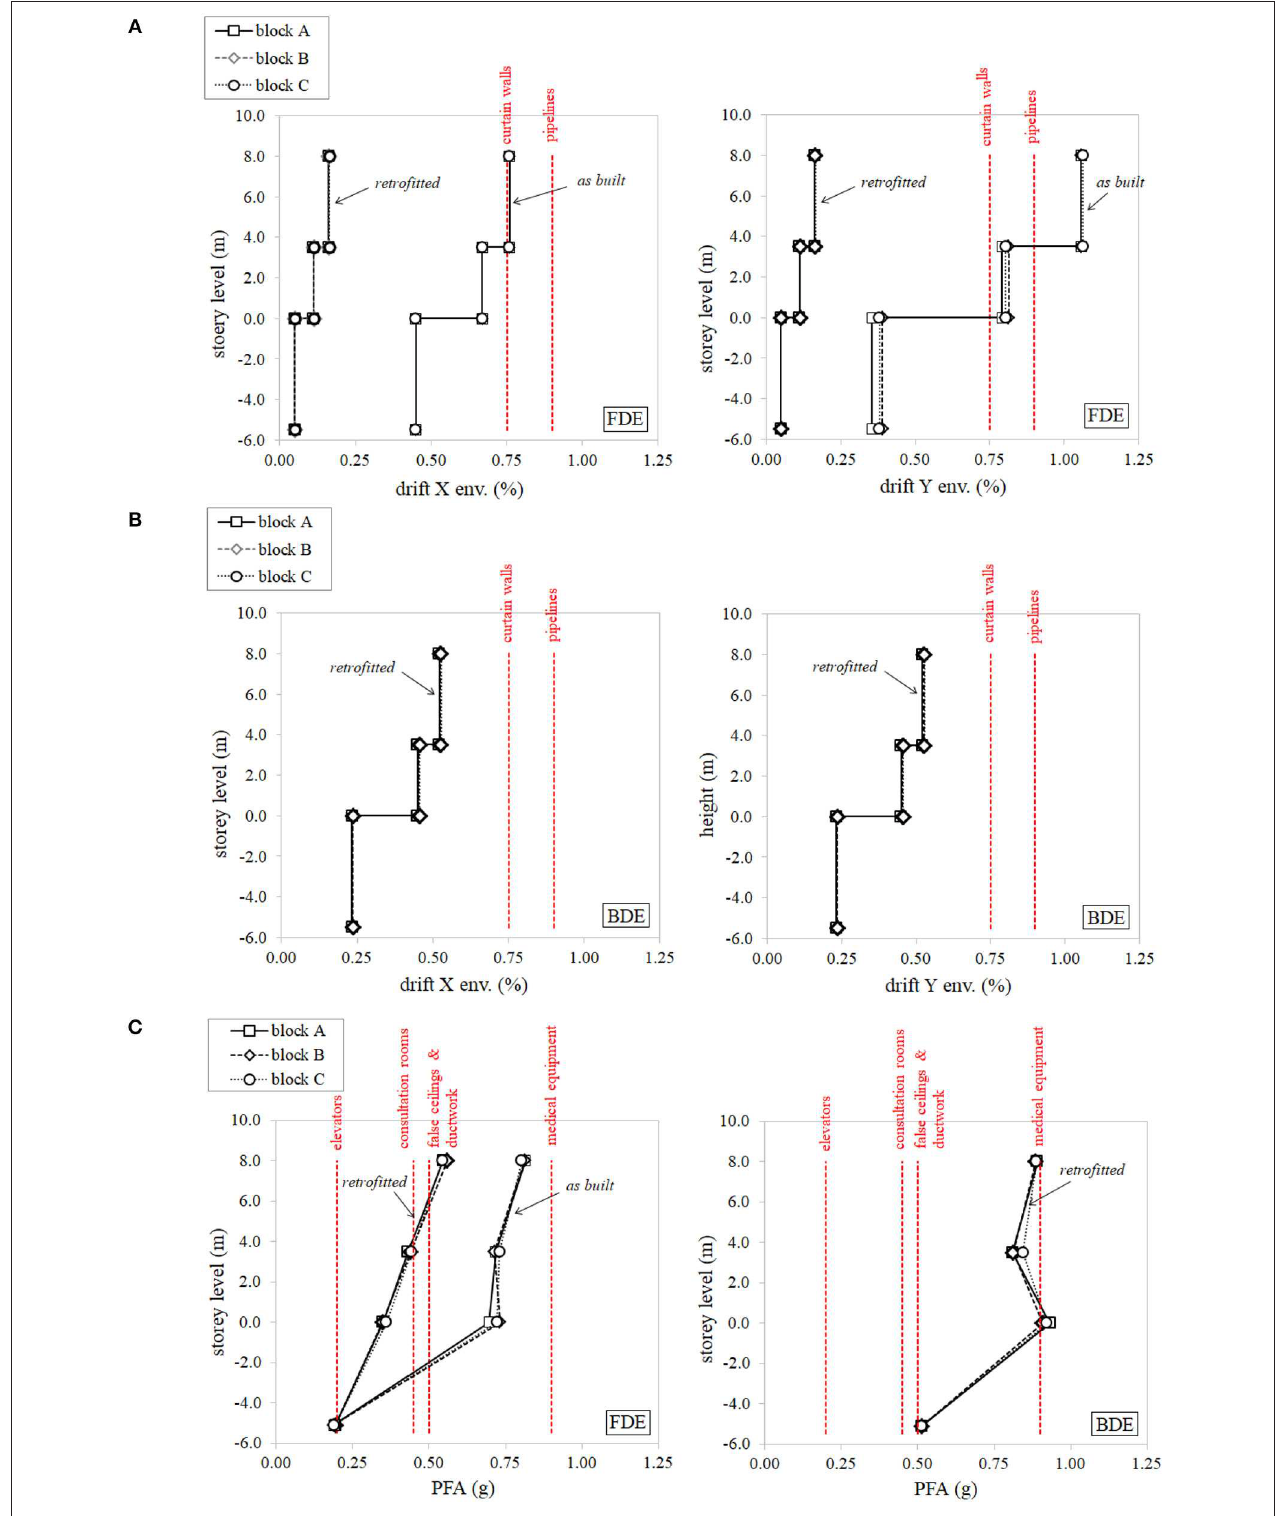
FIGURE 8 | Seismic performance of non-structural components and content (red-dashed lines represent the failure thresholds of the weakest elements). Average inter-story drift envelopes in the longitudinal (X-left) and transversal (Y-right) direction for both (A) FDE and (B) BDE levels. (C) Average peak floor acceleration (PFA) distributions calculated for FDE (left) and BDE